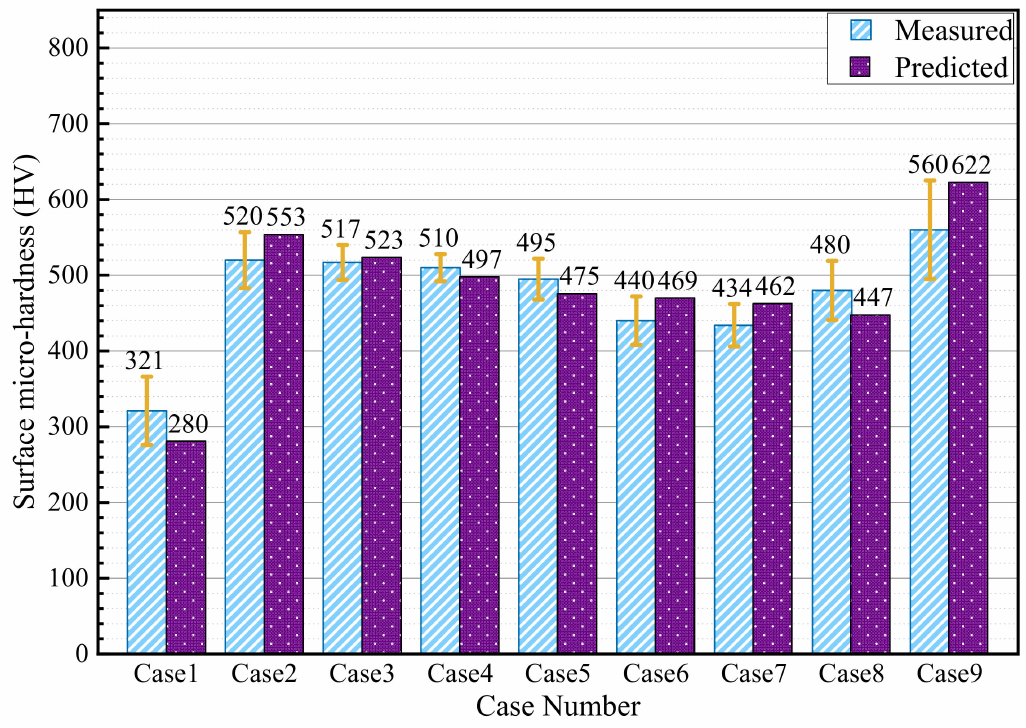
Figure 12. Predicted and measured surface